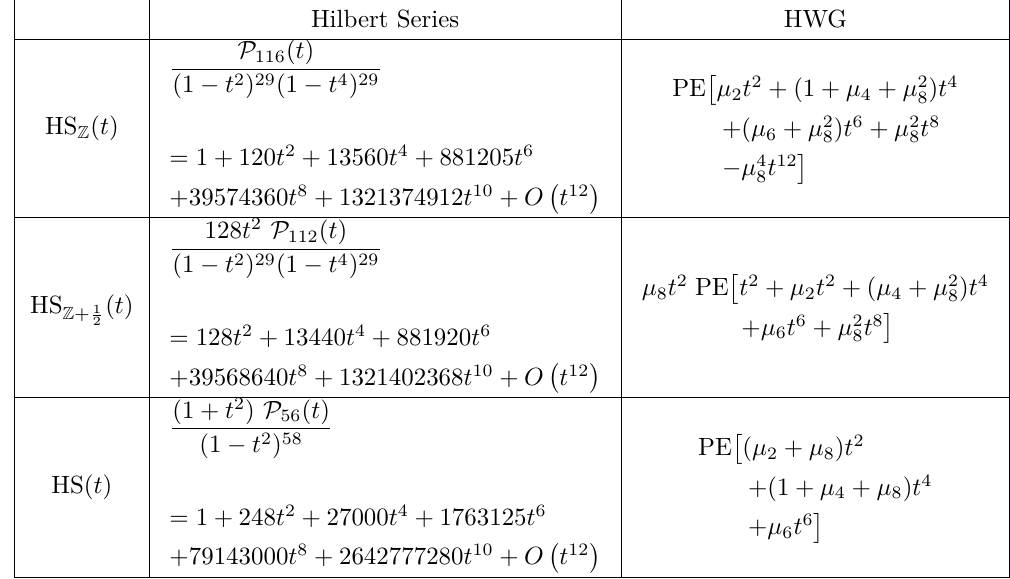
Table 7. Hilbert series for the E 8 magnetic quiver (3.3). The first line of the table provides the Hilbert series when the GNO magnetic lattice is integer HS Z ( t ) , the second line shows the sum over the integers-plus-half lattice HS Z ( t ) and the last line is their sum HS( t ) . The palindromic + 1 2 numerator terms P k ( t ) are given in appendix E. In the third column, we show the HWG in terms of fugacities for so (16) (denoted µ 1 , . . . , µ 8 ). Note that we pick the branching of e 8 → so (16)